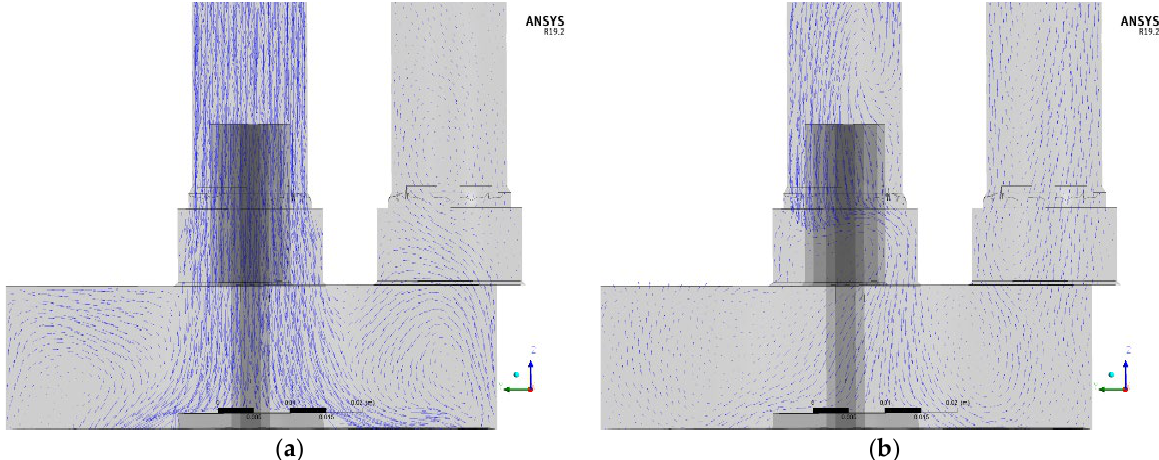
Water 2021 , 13 , 2607 Figure 8. Vectors of water velocity: ( a ) Case 3 and ( b ) Case 2 while watering.